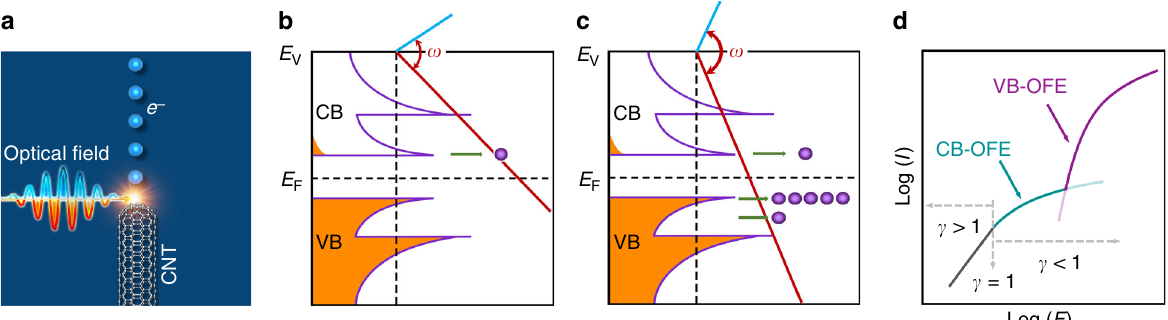
Fig. 1 Operation principle of extreme nonlinear OFE. a Diagram of OFE from CNT. Electrons (blue balls) are emitted from semiconducting CNT, driven by a negative half-cycled (red line) strong electromagnetic fi eld of a femtosecond laser. b Diagram of CB-dominated OFE (CB-OFE) that occurs at a relatively low optical- fi eld strength. The electron- fi lling states (orange) in allowed bands (purple lines) follow the Fermi – Dirac distribution near Fermi level ( E F ). Red and blue lines represent the periodical vacuum level driven by a strong optical- fi eld in negative and positive cycles, respectively, with a circular frequency of ω . Purple balls present the tunneling electrons. c Diagram of transition into VB-dominated OFE (VB-OFE) that occurs when the optical- fi eld strength is increasing. d Illustration of the nonlinear photoemission I – F curve in log – log plot. The upward bending of the curve is a result of transition from CB-OFE (green line) to VB-OFE (red line). Both CB-OFE and VB-OFE follow the FN form ( γ < 1). The difference in emission rates is induced by different electron amounts in CB and VB. Multiphoton photoemission occurs at a low driving fi eld limit ( γ > 1)